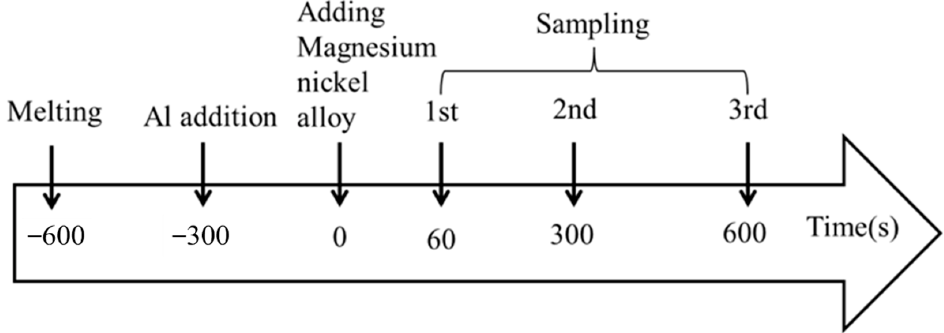
Figure 1. The alloy addition and sampling plan in the